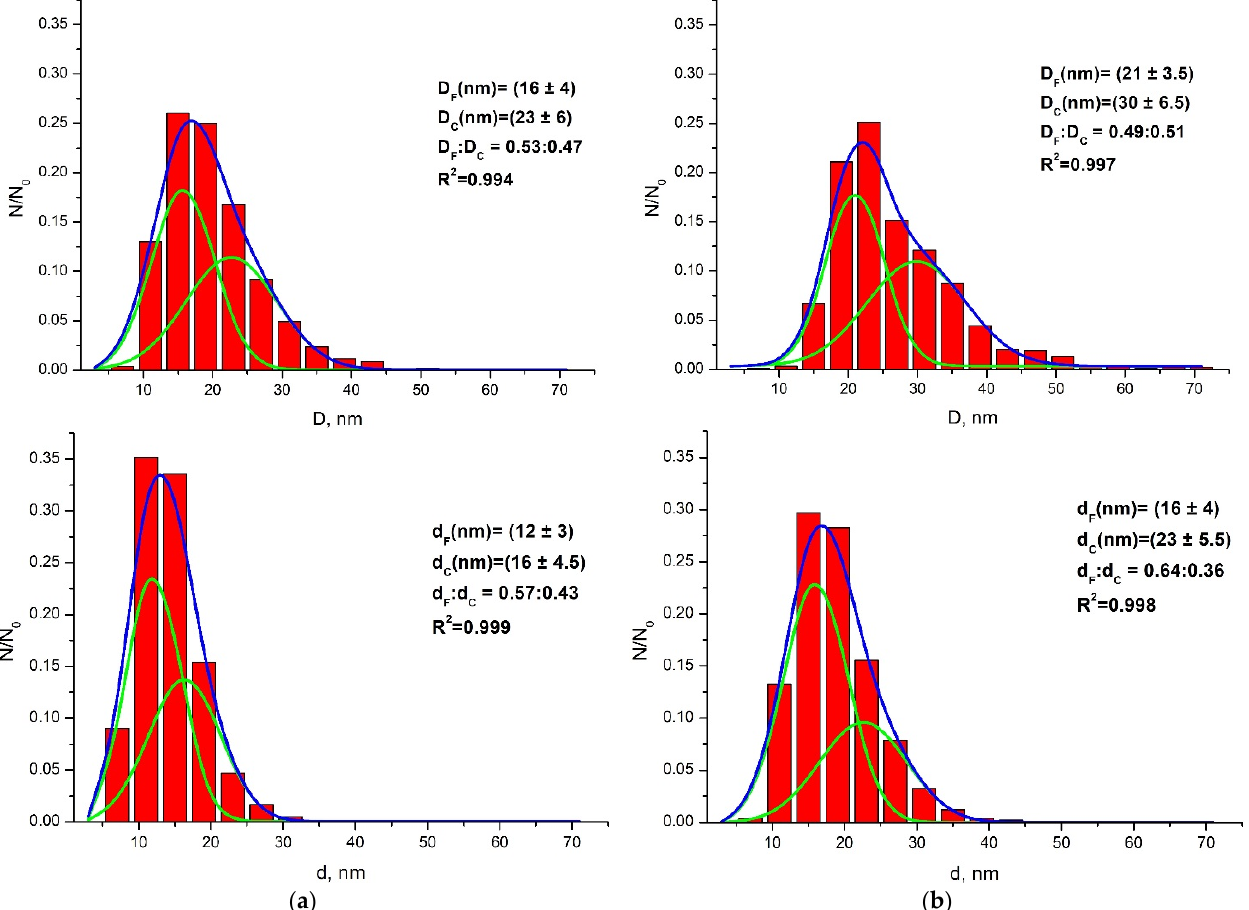
Figure 3. General distribution of NPs of samples of type I ( a ) and type II ( b ) by characteristic sizes, in accordance with fine (Fine, index F) and coarse (Coarse, index C) fractions; the shape of the nanoparticle projections (in TEM images) is approximated by model ellipses with large ( D ) and small ( d ) diameters; parameters D F , d F and D C , d C are the maxima of green curves described by Gaussian functions, the sum of which (blue curve) describes the size distributions of these two fractions of small and large Nd 3+ : LaF 3 NPs.